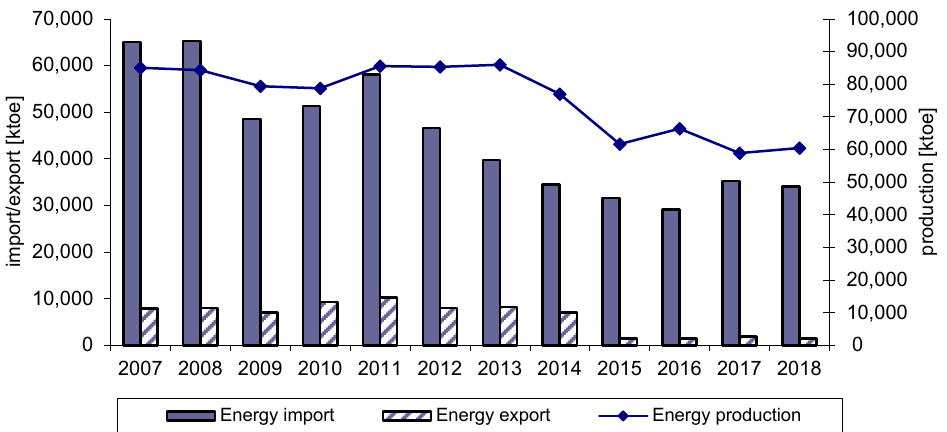
Figure 1. Production, export, and import of energy in Ukraine, in thousands toe. Source: The author’s calculations are based on statistics from the State Statistics Service of Ukraine [23].